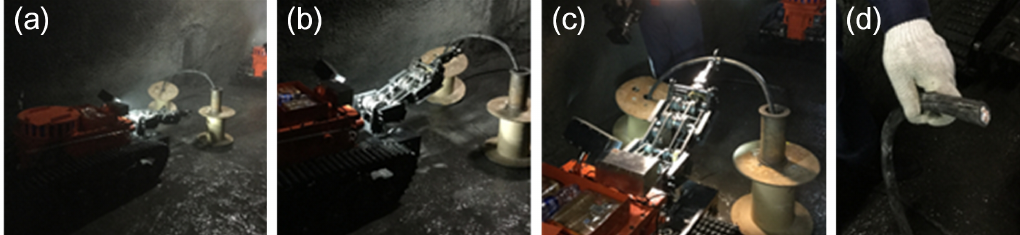
Figure 29. ( a – d ) show that a robot is cutting the cable controlled by OCU far away in the telecontrol control mode. ( a ) shows the robot is preparing to aim at the cable. ( b ) shows the robot has aimed at the cable. ( c ) shows the robot is cutting the cable. ( d ) shows the cable is cut by the